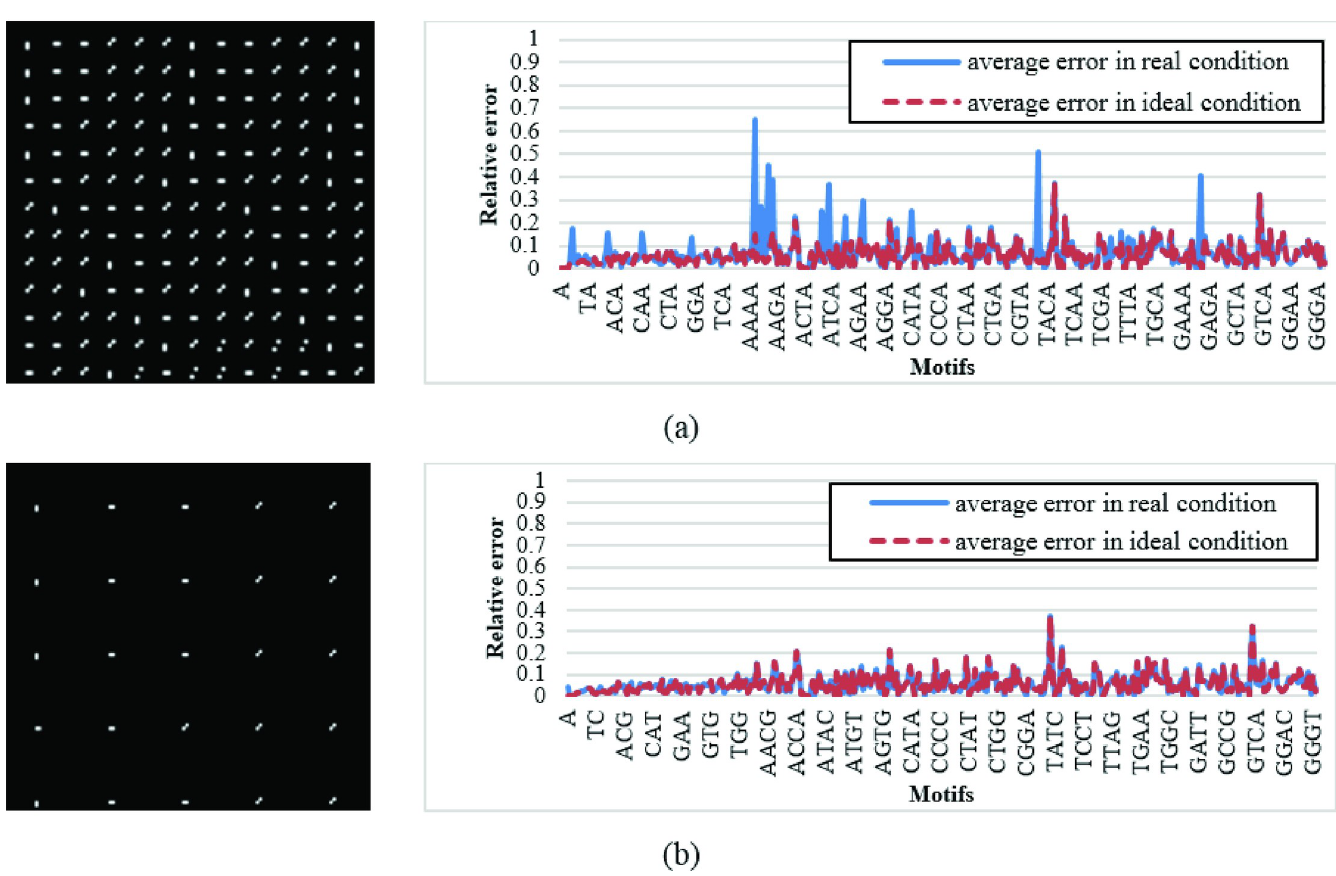
Fig 14. Average relative errors of cross-correlating all motifs with length 1 to 4 with first 1260 bp of first 12 chromosomes of Homo sapiens GRCh38.p12 data (sequences are encoded using coding set with d = 3, N = 2, E = 0 and score equal to 0, while each line of SLM cosist of 42 columns). On the left, a part of the coded reference sequence is shown, while on the right, average relative errors resulted from optical simulation is compared with that of bahaviolral simulationconsidering free boundary of width a) 2 pixels and b) 10 pixels around each nocletide code.